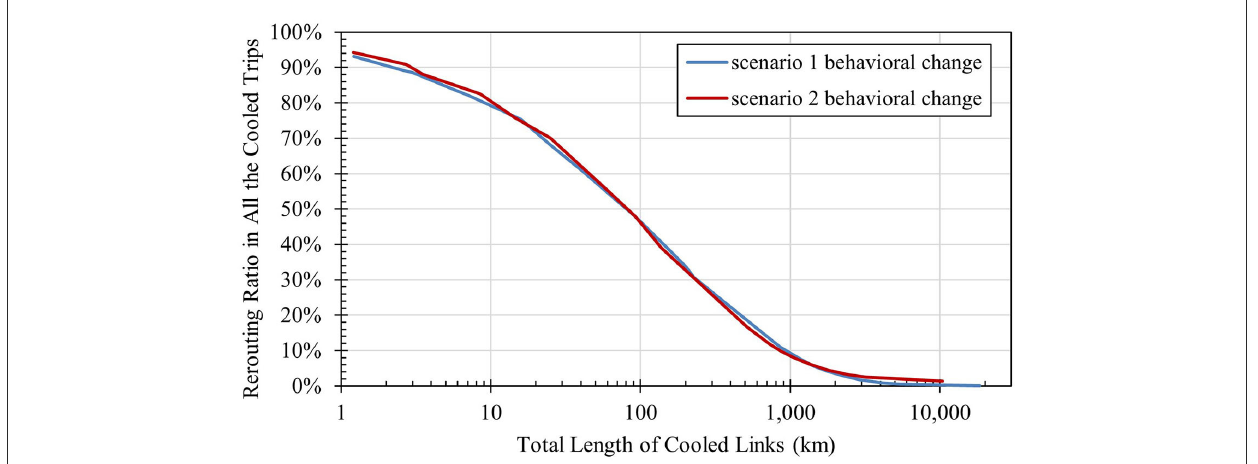
FIGURE5 Ratio of trips cooled by rerouting under different cooled networks. The x-axis represents the total length of the network selected to get environment change. The y-axis represents the ratio of trips that get heat mitigation benefits from rerouting. The blue line represents the street cooling condition in scenario 1 where the roadways’ temperature is reduced to the lowest 10%. The red line represents the street’s cooling condition in scenario 2 where the roadways’ temperature is reduced to the lowest